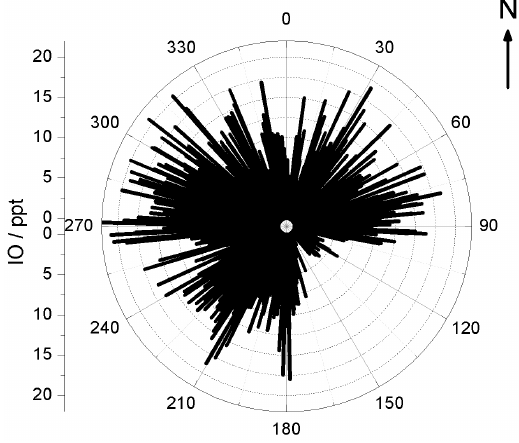
Fig. 7. A wind rose of IO concentrations to demonstrate the depen- Fig.7. AwindroseofIOconcentrationstodemonstratethedependenceofIOconcentrationsonwinddirection(150saverageddataforthe entirecampaign). Awinddirectionof90to180degreescorrespondstoaprevailingwindfromthetown. dence of IO concentrations on wind direction (150 s averaged data for the entire campaign). A wind direction of 90 to 180 degrees corresponds to a prevailing wind from the